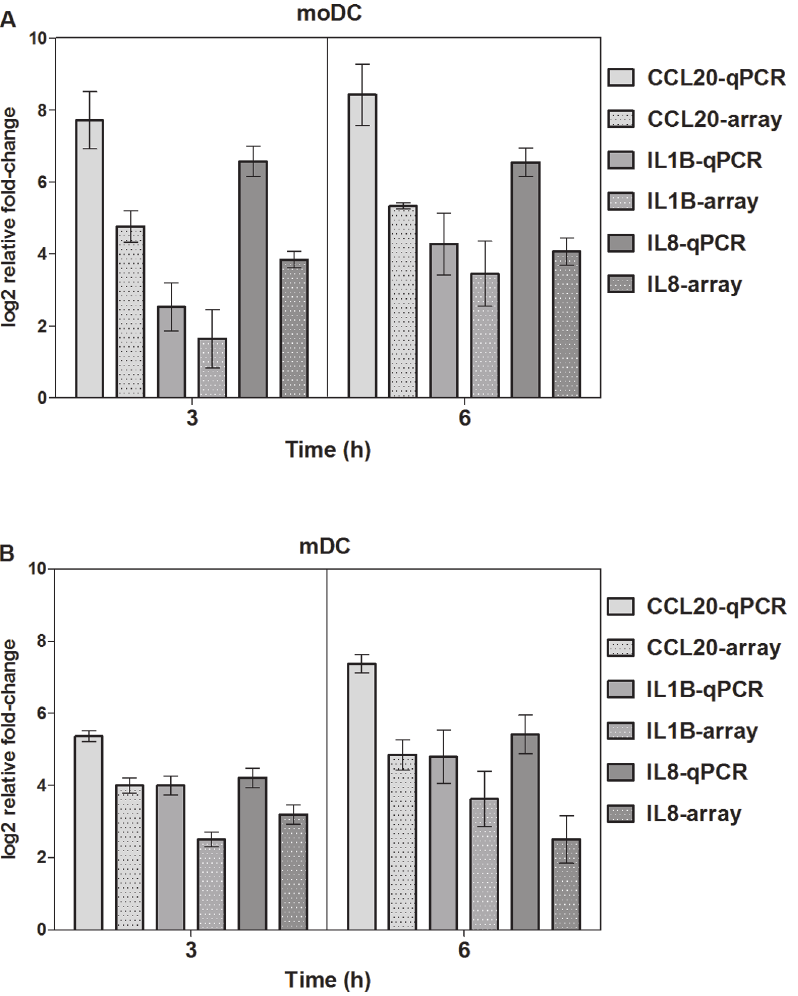
Figure 2. RT-qPCR validation of differential gene expression observed in microarray experiments measuring cellular interactions involving (a) moDC and (b) mDC. Gene expression data from the immune gene microarray shown as mean log 2 values of ratios of relative expression determined by RT-qPCR compared to array data. Error bars in both charts indicate the standard error.